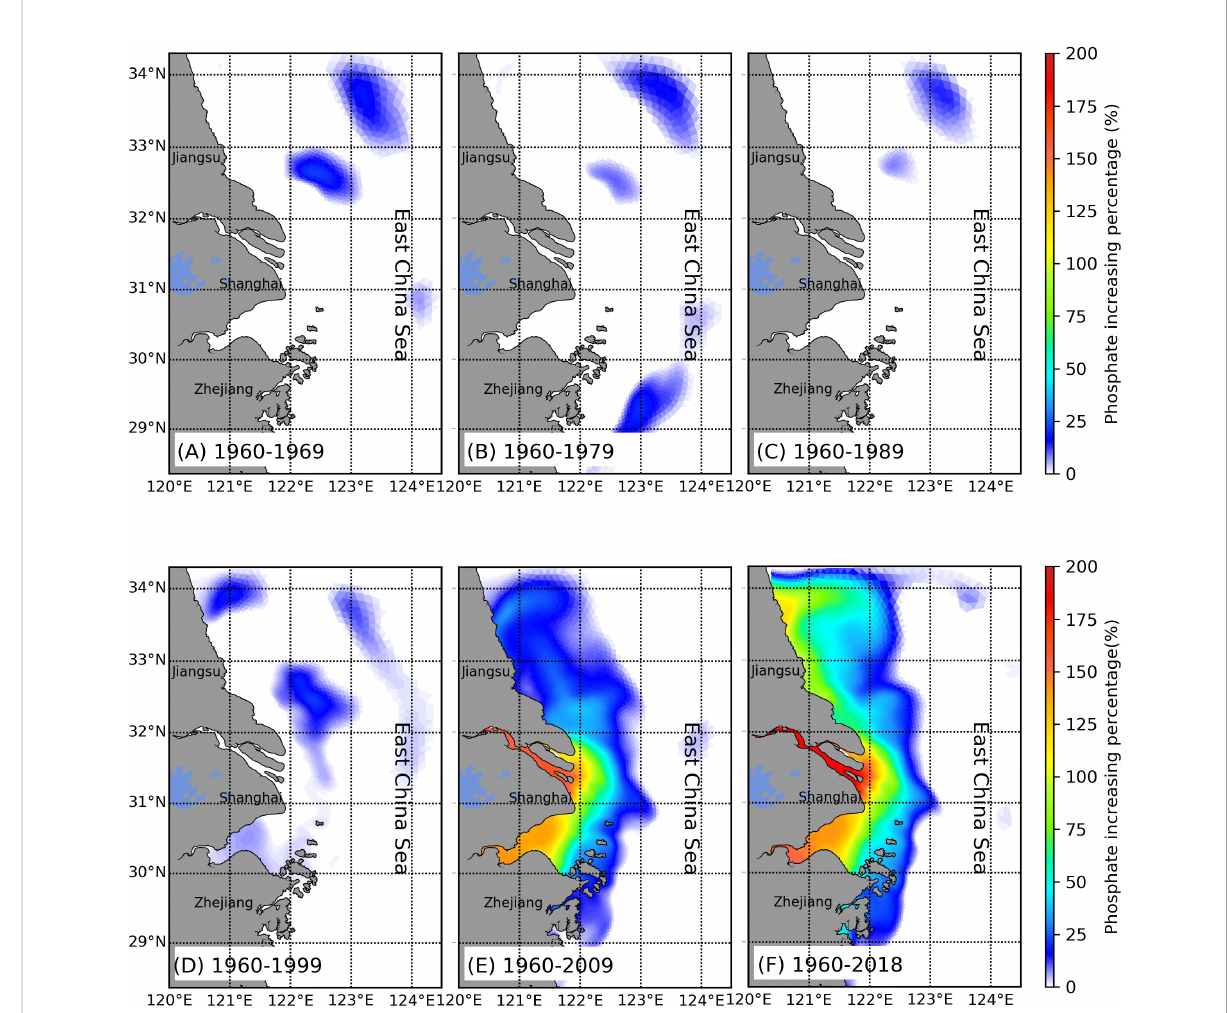
FIGURE 10 Distribution of changing percentage in the phosphate concentration during (A) 10 years, (B) 20 years, (C) 30 years, (D) 40 years, (E) 50 years, and (F) 60